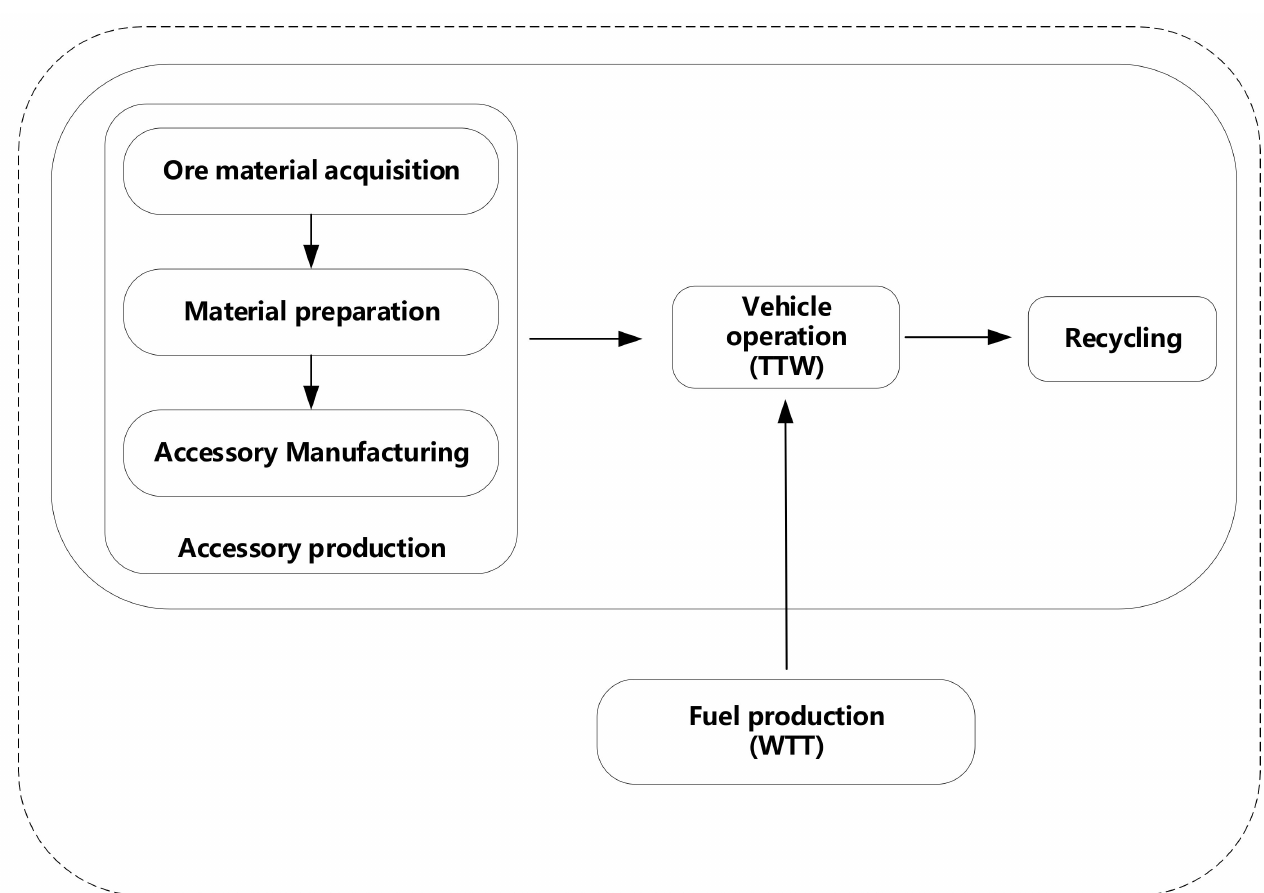
Figure 1. System boundary of this